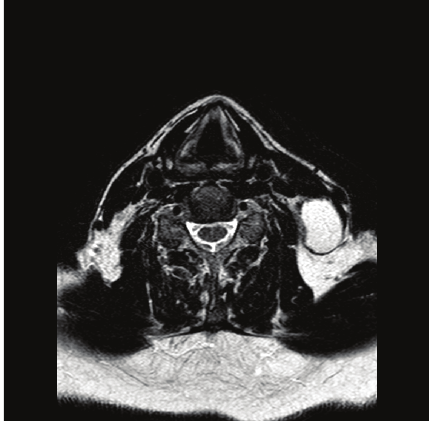
Figure 2: Axial slides of T2-weighted MRI showing a hyperintense cystic lesion behind the left sternocleidomastoid muscle in the neck level